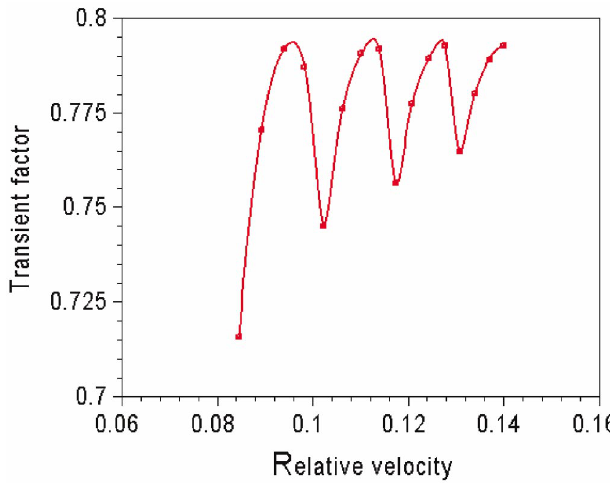
FIG. 17. (Color) Transient factor vs relative velocity for the second version of cavity-cavity matching.